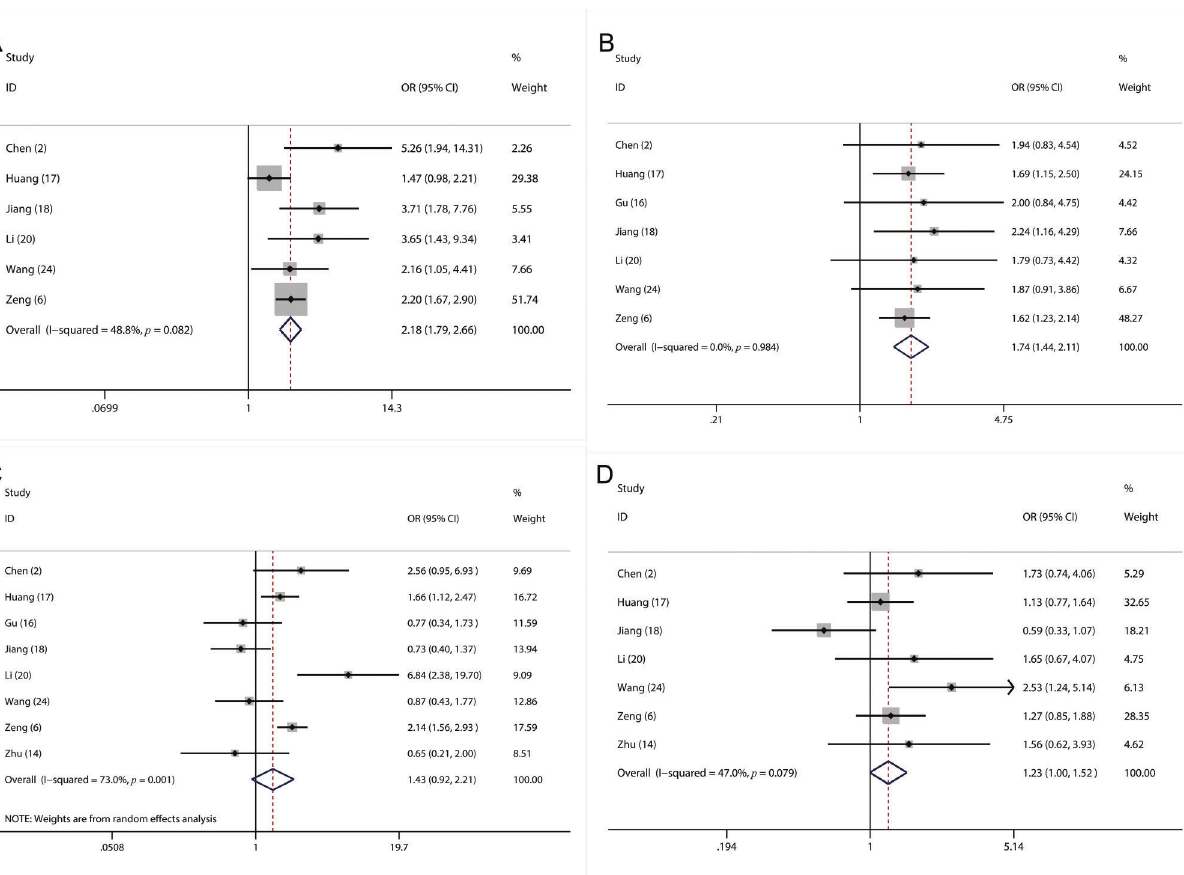
Figure 5 - Forest plot of the odds ratios (ORs) for the association of the plasma fibrinogen level with TNM stage (A), lymph node metastasis (B), sex (C) and age (D).